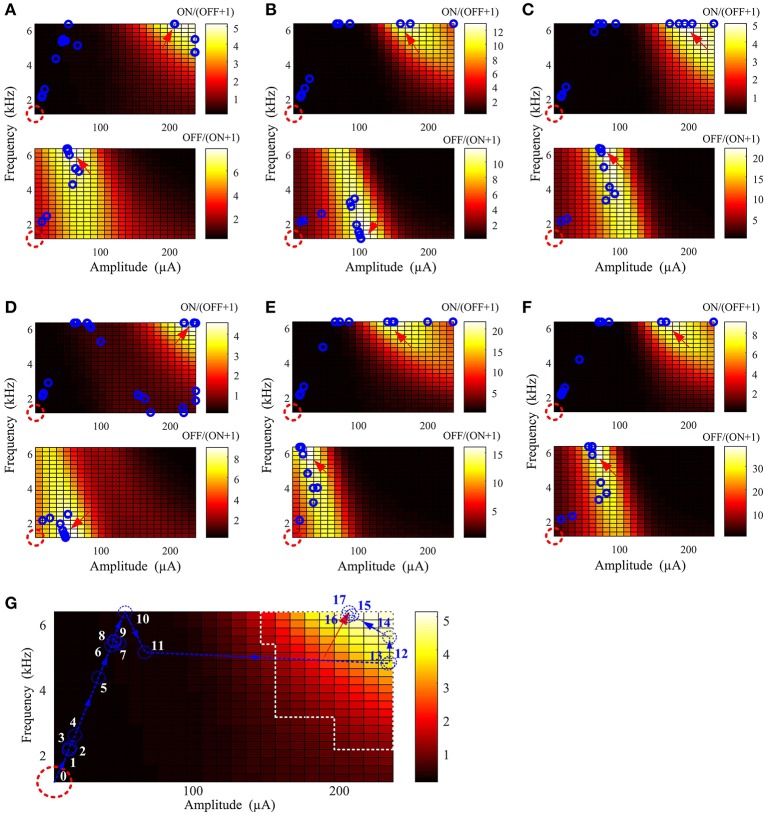
Optimal stimulation amplitude and frequency can be determined using a well-defined cost function, minimized with an interior point algorithm. (A–F) Six examples of parameter searching with different virtual ON and OFF populations. In each panel, the red dashed circle represents the starting point and the red arrow indicates the location where the search was terminated. Intermediate search points at each new iteration are represented by the blue circles. In all results, the optimal stimulus parameters were successfully found regardless of variations across the virtual RGC population. (G) An example search path. Each iteration is sequentially labeled from 0 (initial point) to 17 (final iteration). The region outlined by white dashed lines is the optimal stimulation parameter space in Figure 2C. The last six iterations (blue numbers) before the search was terminated were within the optimal parameter space defined by Table 2.